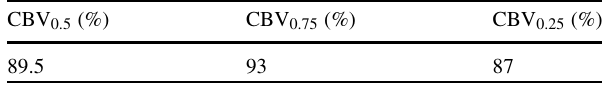
Table 7 CBV quantiles for median estimation